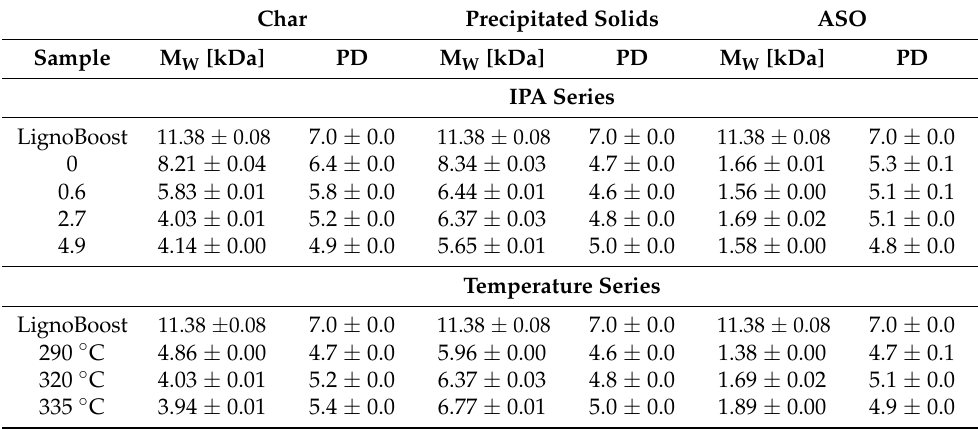
Table 3. Mass average molar mass (M W ) and polydispersity (PD), with standard deviations, of the product